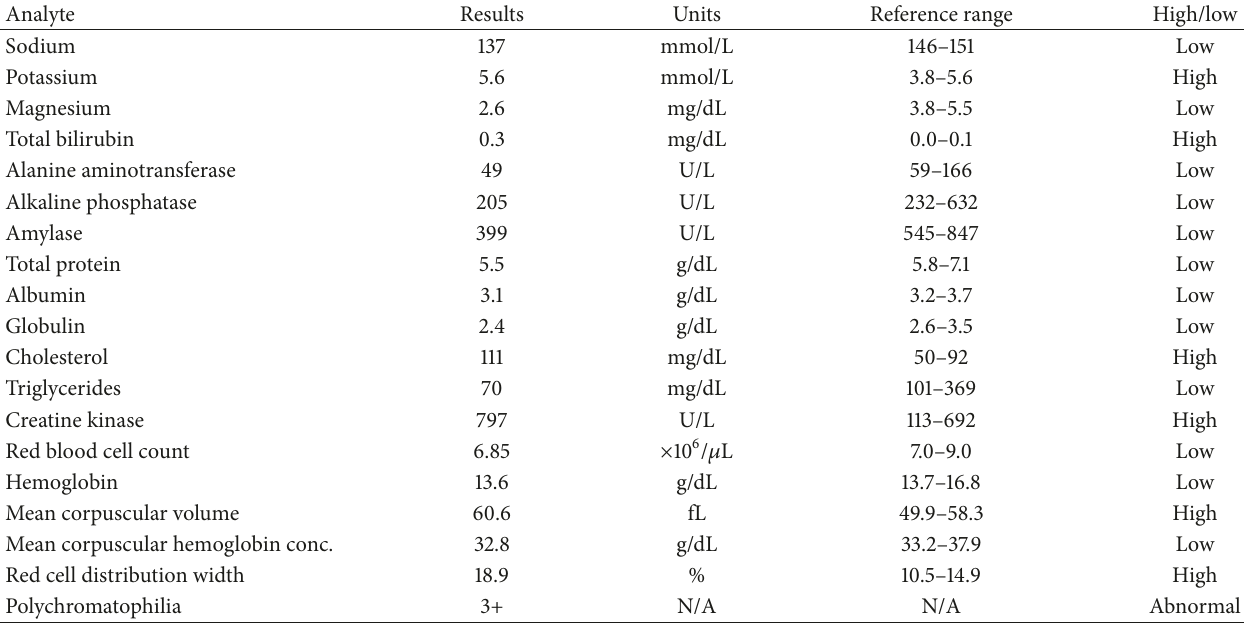
Table 2: Summary of relevant blood test results from the cardiac puncture from one